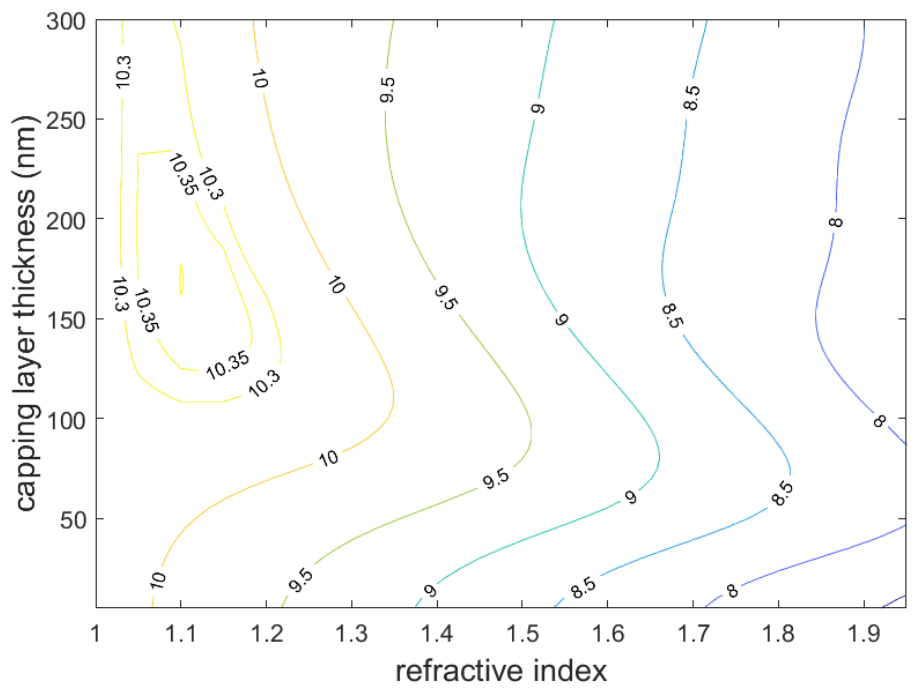
Figure 12. J SC for various values of n and the thickness of a conceptual “filler medium” also forming a capping layer.